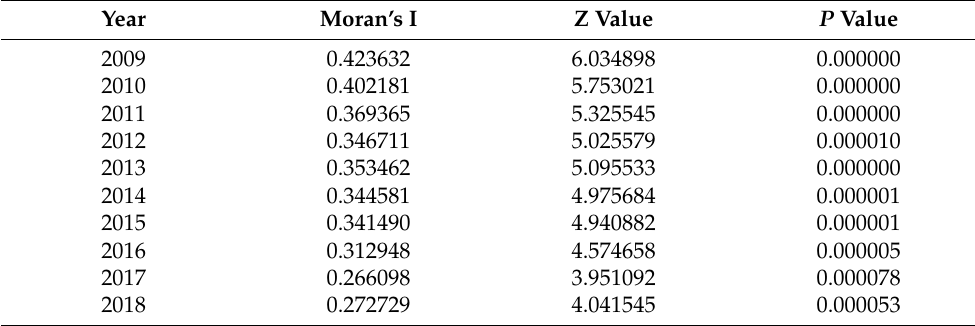
Table 7. Global Moran’s I Index of the coordination degree in regard to carbon emissions, economic development, and environmental